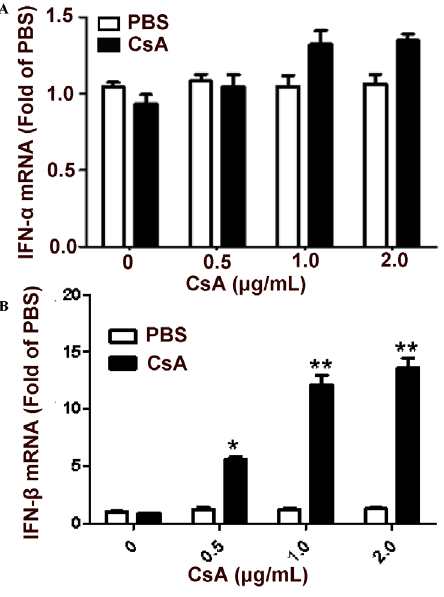
Figure 3. Effect of cyclosporin A (CsA) on type I interferon expression. Wa rotavirus-infected HT-29 cells were treated with CsA at indicated doses at 12 h post-infection. Total cell lysates were collected at 24 h post-treatment. Total cellular RNA extracted from the total cell lysates was subjected to the real-time RT-PCR to quantify IFN- a (A) and IFN- b (B). IFN- a /IFN- b expression is expressed as mRNA levels relative (fold) to the control (uninfected HT-29 cells without CsA treatment, which is defined as 1). Data shown are expressed as mean 6 standard deviation of triplicate cultures, and 3 independent experiments were carried out (* P , 0.05, ** P ,